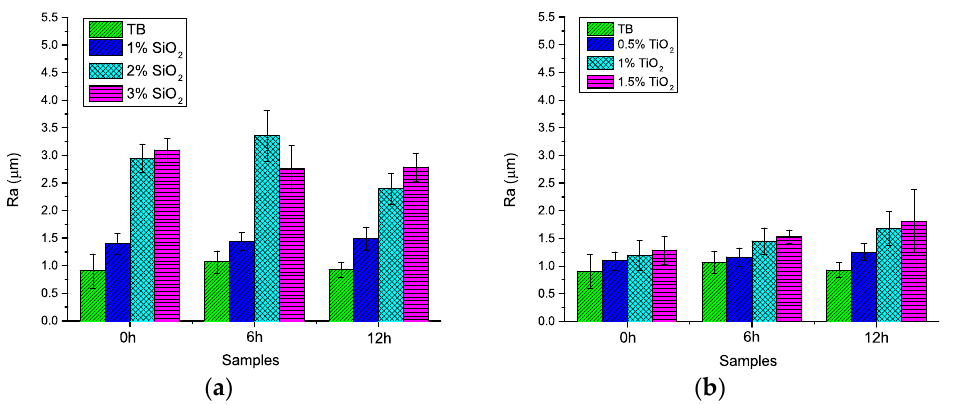
Figure 8. Results of the measurement of R a parameter of the unaged and aged FC with addition of ( a ) SiO 2 and ( b ) TiO 2 nanoparticles.